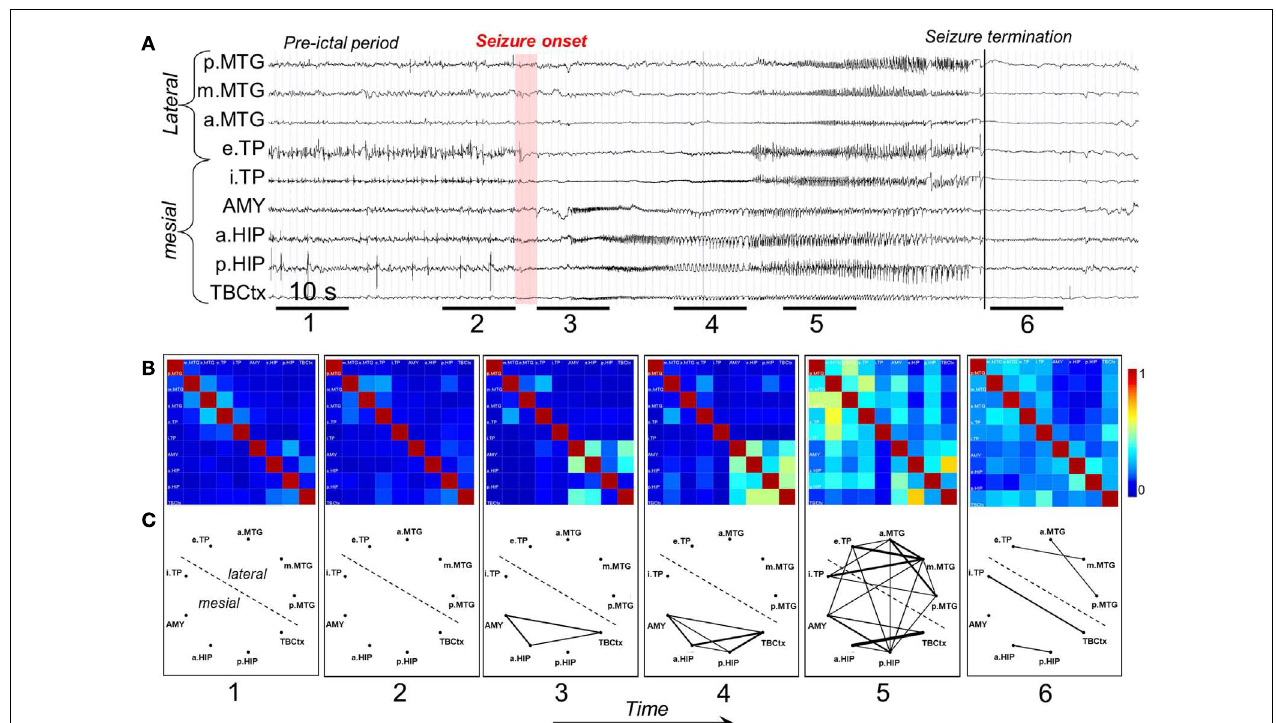
after seizure termination (6). (C) Graphical representation in which the lines indicate “abnormally strong” couplings between the two considered structures (graph nodes). Only significantly high interdependencies are represented (i.e. h2 values ≥ 0.32.This value corresponds to the average h2 value computed over the interictal period ± 2 SD). Line thickness is proportional to h2